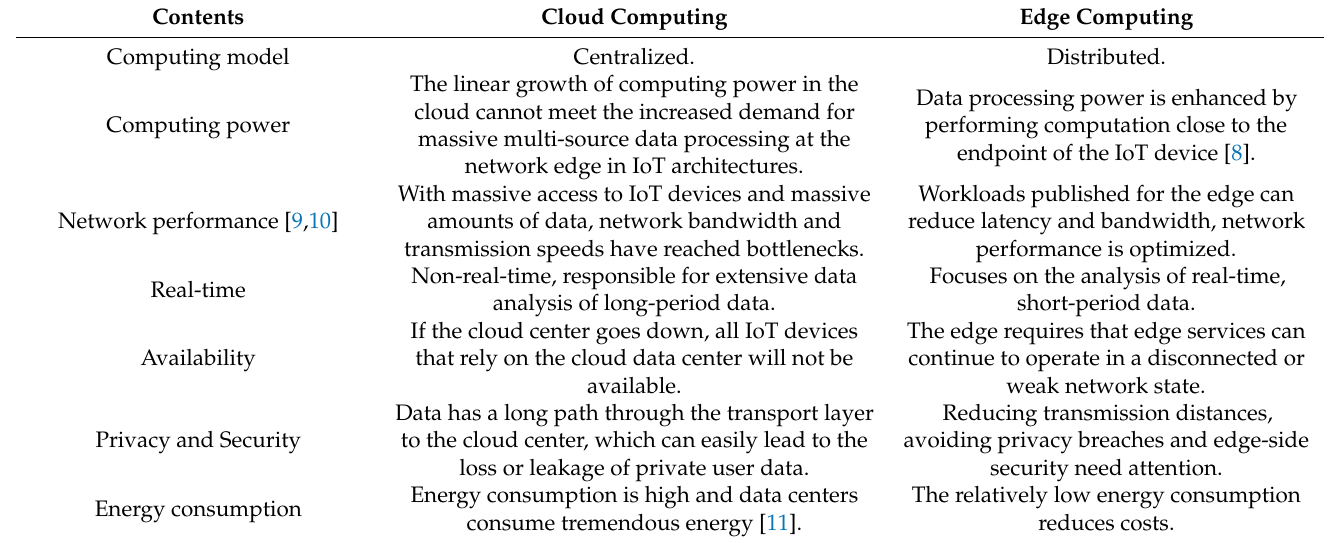
Table 1. Cloud computing vs. edge computing in the IoT architecture.